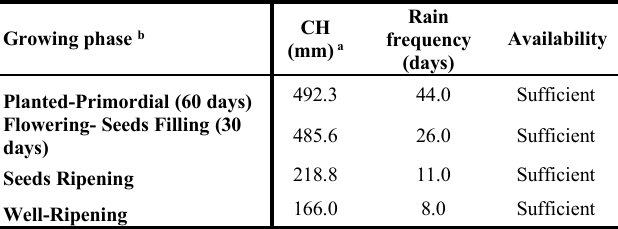
Table 1 : Average rainfall during the growth of hybrid rice in irrigated lowland of Bojong village, Cikembar district, Sukabumi,